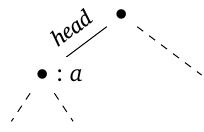
Instantiation of the logical constraint for p